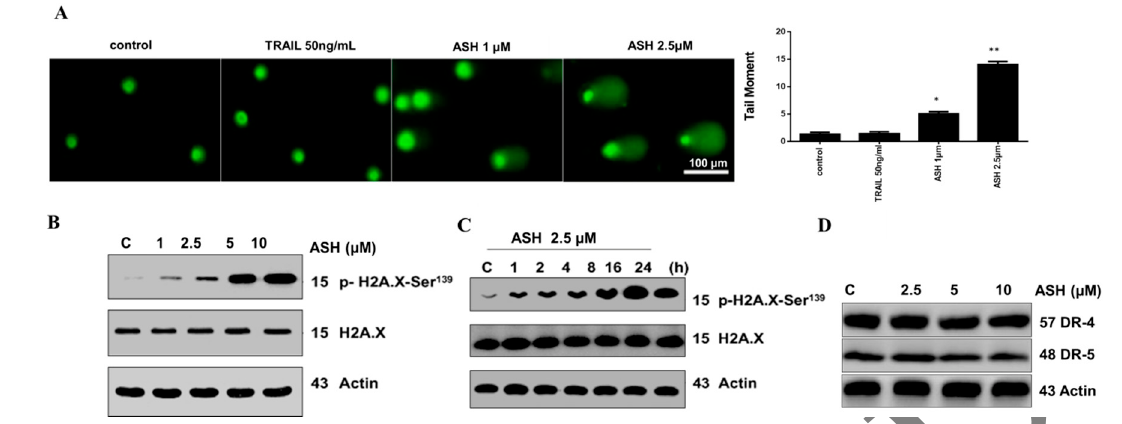
Figure 5. ASH promotes DNA damage and H2A.X phosphorylation in HepG2 cell. ( A ) DNA Damage caused by 1–2.5 μ M ASH was measured by the Comet Assay for 20 minutes. Tail moment was used to measure the double strand breaks by calculating the percentage of tail DNA x tail length.